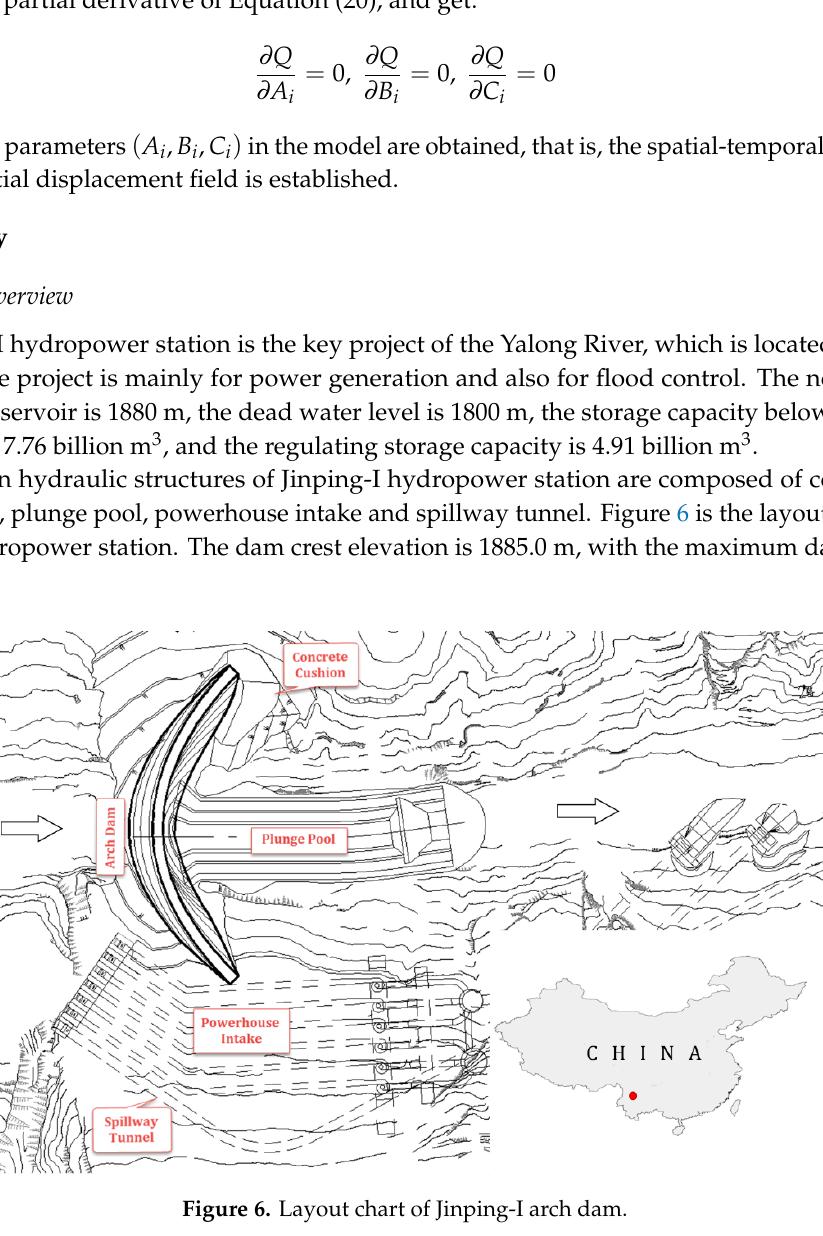
Figure 7. Layout of the pendulum system of Jinping-I arch dam. Figure 7 shows that the distribution of pendulum system is roughly uniform along the height direction, the same in the left and right bank direction, which can reflect the deformation state of the dam comprehensively. Figure 7 shows the rationality and effectiveness of the pendulum system. 4.2. Deformation Data Representation In order to show how to use the spatial panel data representation method to express the deformation data, radial displacements of No. 16 dam section are taken as an example. The relative radial displacement distribution of PL16-1~PL16-5 measuring points on the dam section is shown in